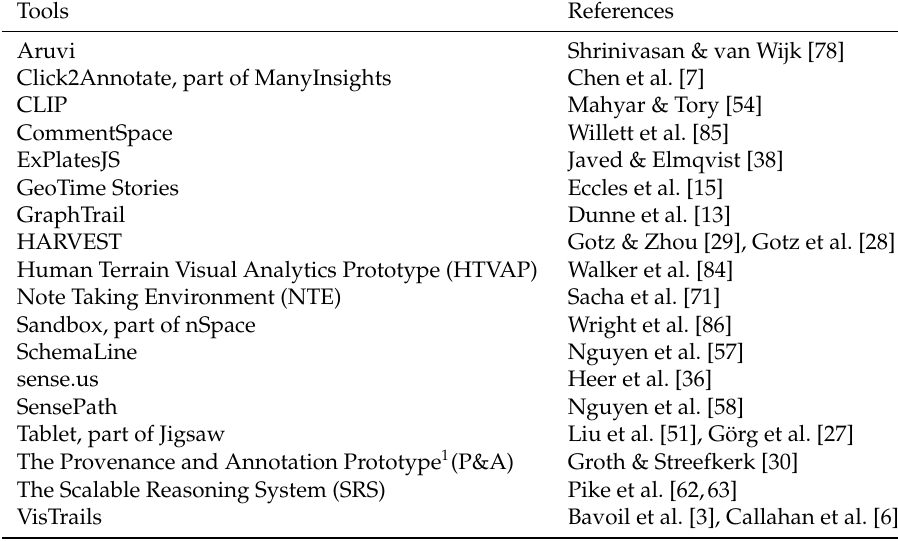
Table 1: The eighteen tools that made it to the paper, and their abbreviations when applicable, listed in alphabetical